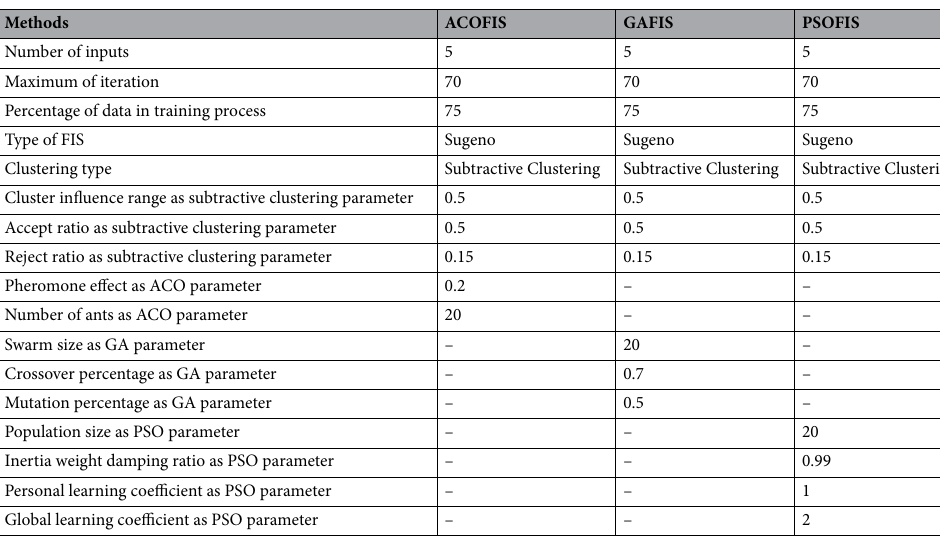
Table 1. Model parameters in the generation of FIS and clustering classification for ACO, GAFIS, PSOFIS algorithms.